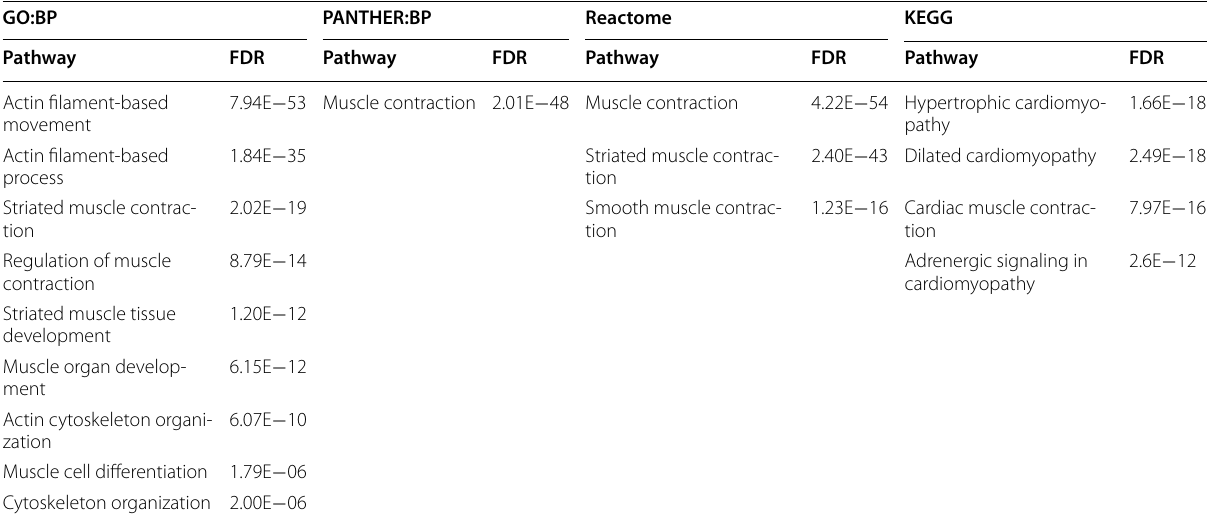
Table 3 Pathways associated with the interacting proteins (identified through STRING database)